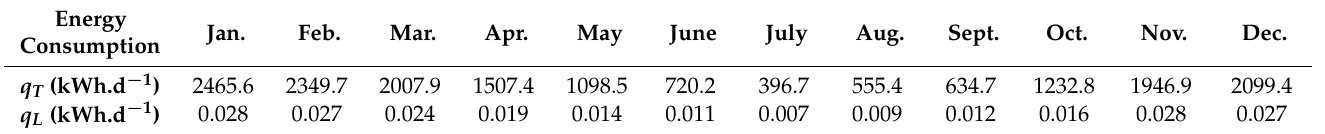
Table 4. Energy consumption of anaerobic BW and KR